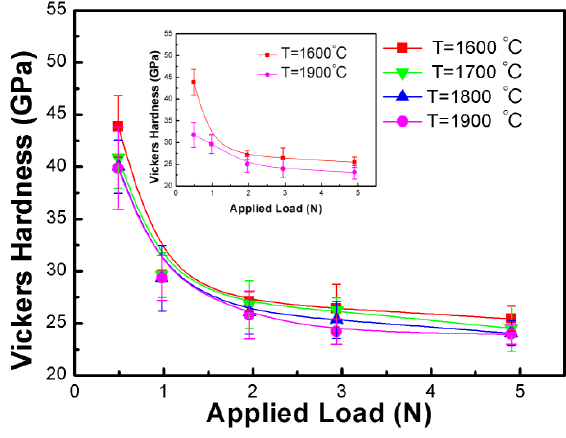
Figure 3. The asymptotic-hardness of WB 2 synthesized at temperatures of 1600 °C to 1900 °C with the pressure at 5.2 GPa for 15 min.